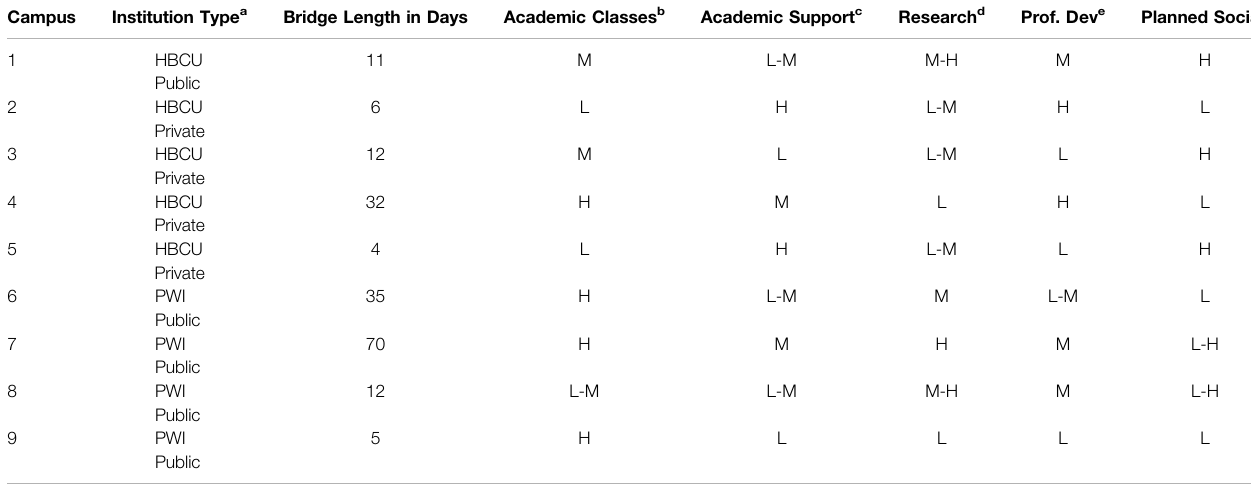
TABLE 1 | Description of Summer Bridge Activities for Each